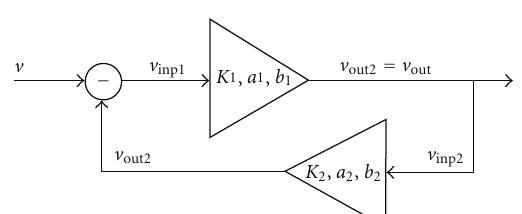
Figure 1: Two-stage amplifier.